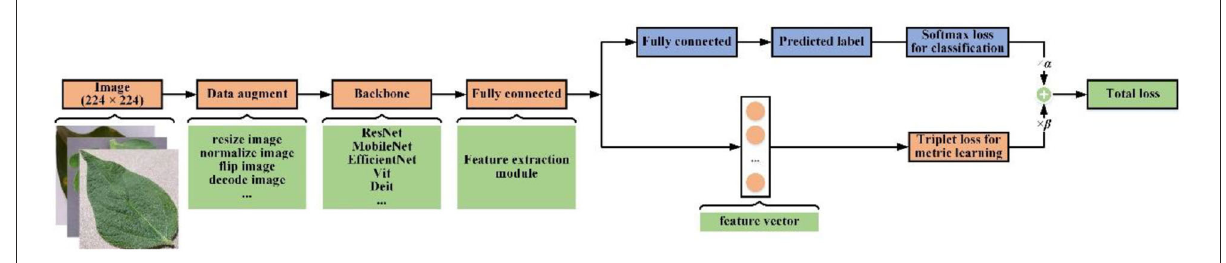
FIGURE5 The feature extraction network structure diagram.